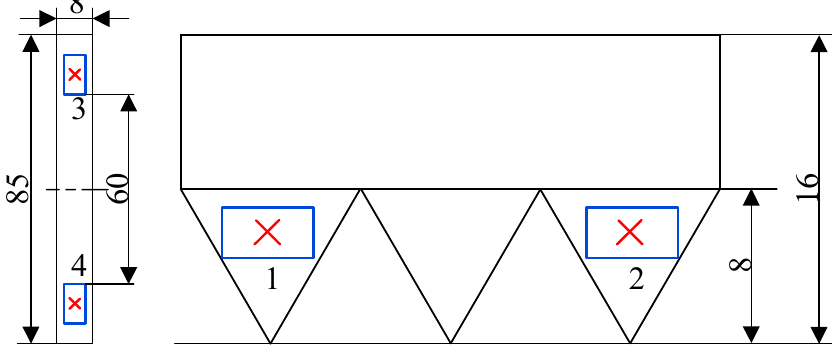
Figure 3. Insertion of Teeth of Spreader to Clamp Experimental Strain Gauge.